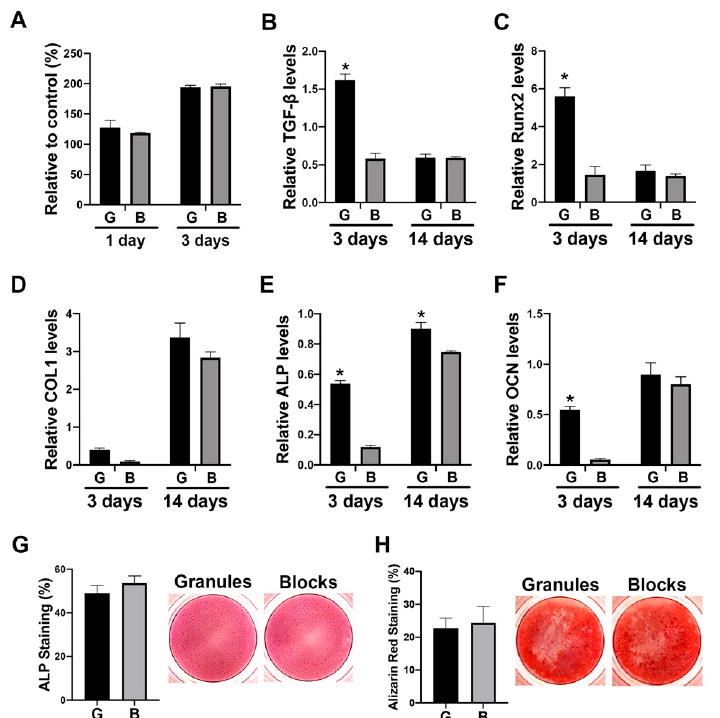
Figure 4. Osteoblast di ff erentiation in conditioned media from M ϕ s cultured on either DBBM granules or blocks. ( A ) Viability assay of Saos-2 cells stimulated in conditioned media from M ϕ s cultured on DBBM granules (shown as “G”) or blocks (shown as “B”) on days 1 and 3. ( B – F ) Real-time PCR of Saos-2 cells seeded in conditioned media from M ϕ s cultured on DBBM granules or blocks for genes encoding ( B ) TGF- β , ( C ) Runx 2, ( D ) COL1, ( E ) ALP, and ( F ) OCN on days 3 and 14 after cell seeding. (* Denotes significantly higher than the other group, p < 0.05). ( G ) ALP staining of Saos-2 cells cultured in conditioned media for 7 days. ( H ) Alizarin red staining of Saos-2 cells cultured in conditioned